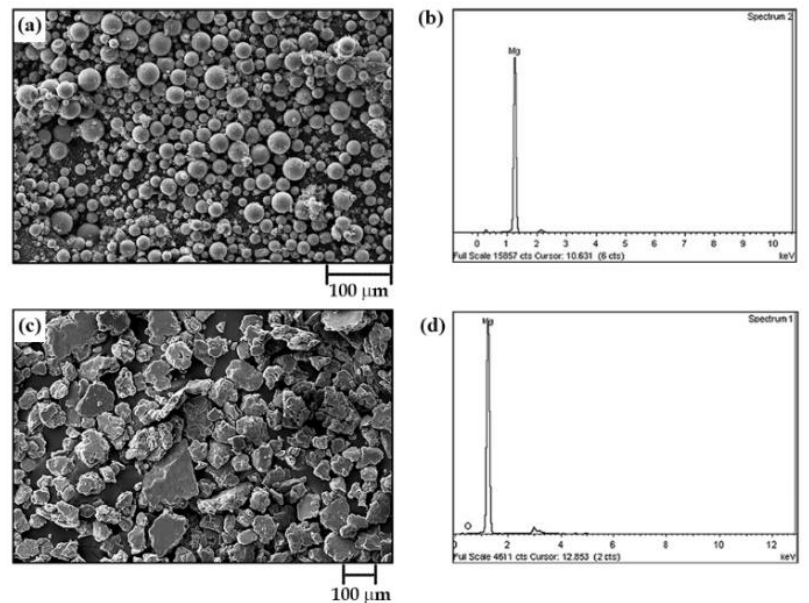
Figure 3. Scanning electron micrograph (secondary electrons) and EDX chemical analysis of ( a , b ) as-received magnesium powders and ( c , d ) sample labeled as M1 (see Table 1).